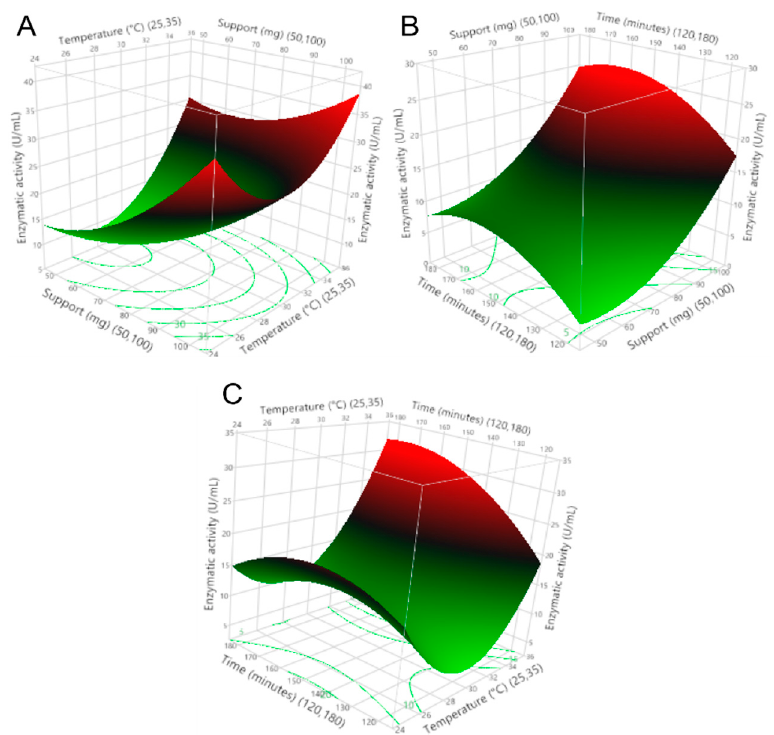
Figure 2. Response surfaces of ( A ) amount support–immobilization temperature vs. enzymatic activity, ( B ) immobilization time–amount support vs. enzymatic activity, and ( C ) immobilization time–immobilization temperature vs. enzymatic activity. Table 2. Response surface regression coefficients: Enzymatic activity vs. amount support, immobi- lization temperature, and immobilization time (coded coefficients).